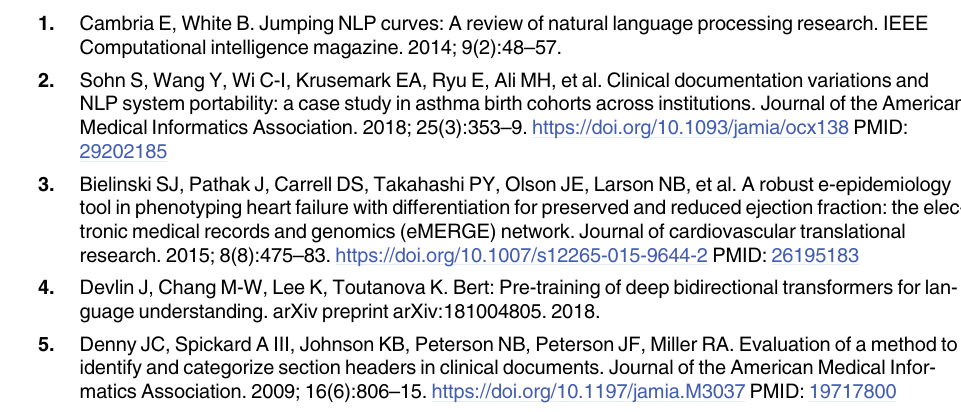
S1 Table. Differentiation of corresponding sections and subsections among corpora. a One clinical document standard of IC Chart Electronic Health Record (EHR) consists of sections ‘S,’ ‘O’, ‘A,’ and ‘P.’; The “Impression and Plan” section of the Cerner EHR, corresponds to “the Assessment and Plan” section of the General Electronic Centricity (GEC) EHR, which contains information on the “Problem,” “Medications,” and other sections; “Chief Complaint and Reason for Visit” sections of the Epic EHR are similar to “Problem” sections of the GEC